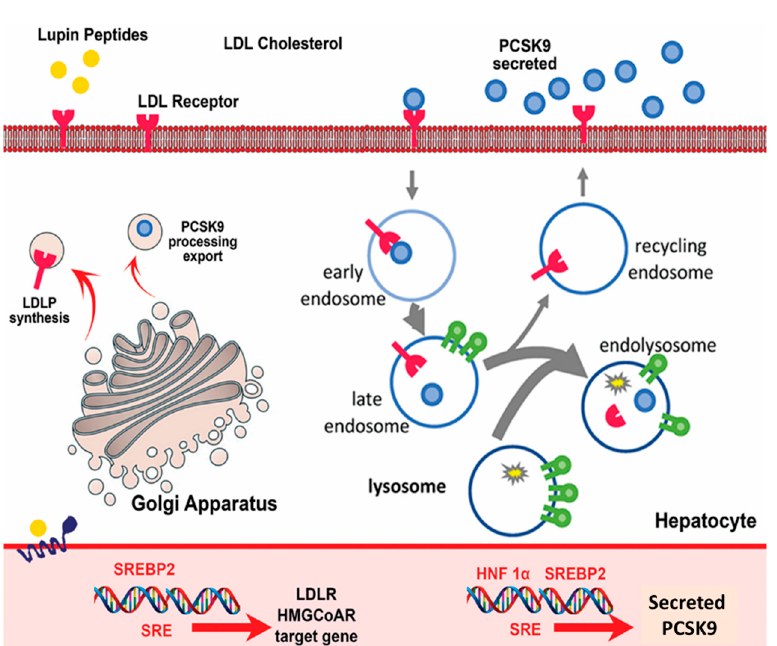
Figure 3. Mechanism of action of cholesterol-lowering peptides indicates the summary of the hypocholesteromic mechanisms of lupin protein-derived peptides in hepatocytes. Lupin protein represent the cholesterol-lowering effects targeting PCSK9: from clinical evidence to elucidation of the in vitro molecular mechanism using HepG2 cells. Table 2. Cholesterol-lowering peptides. Mechanisms underlying the hypocholesterolaemic activity of peptides. Peptide Source